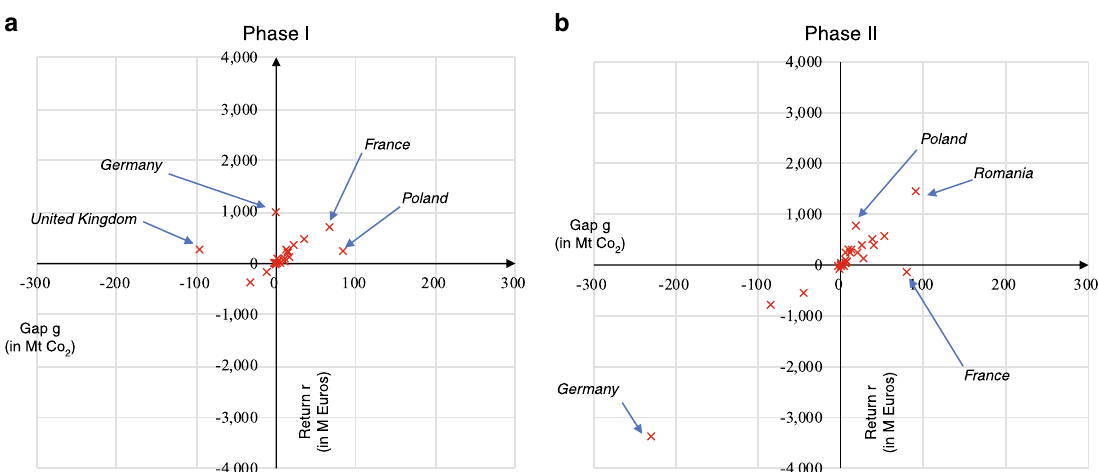
Fig. 4 State-level trading performance based on the aggregation of the fi rm-level trading data. The participating states are plotted on the g – r coordinate system, where the combined g and r of all fi rms that belong to one state are employed as the coordinates of the state. States with abnormal trading pattern (i.e., states with g – r coordinates that are not in the generic cluster) include the UK, Germany, France, Poland, and Spain in Phase I ( a ); and Germany, France, Poland, and Romania in Phase II ( b ). Generic cluster refers to the linear sector where the coordinates of the majority of the states